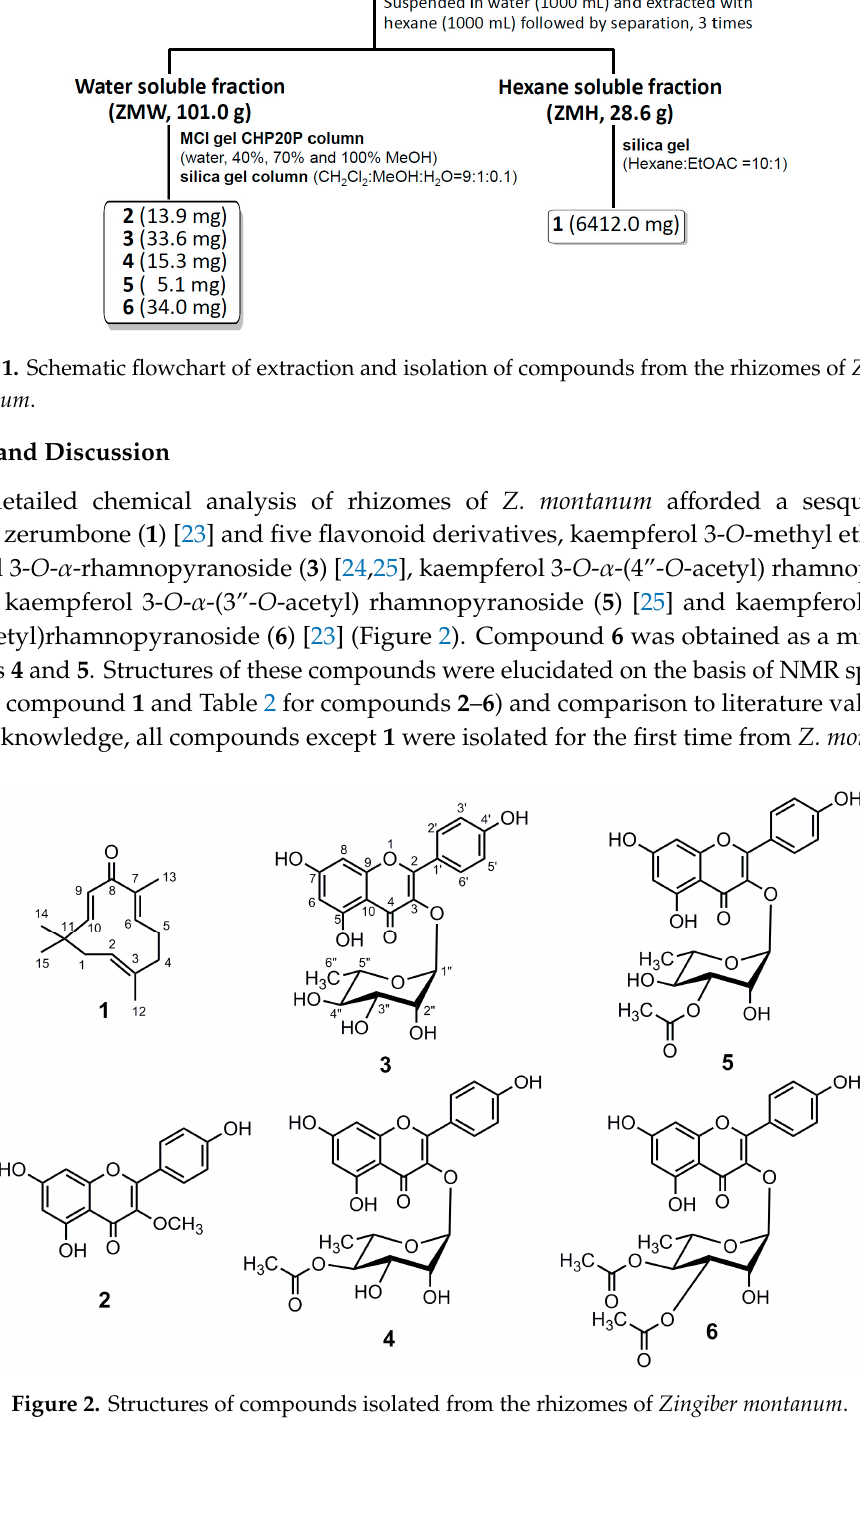
Figure 2. Structures of compounds isolated from the rhizomes of Zingiber montanum .